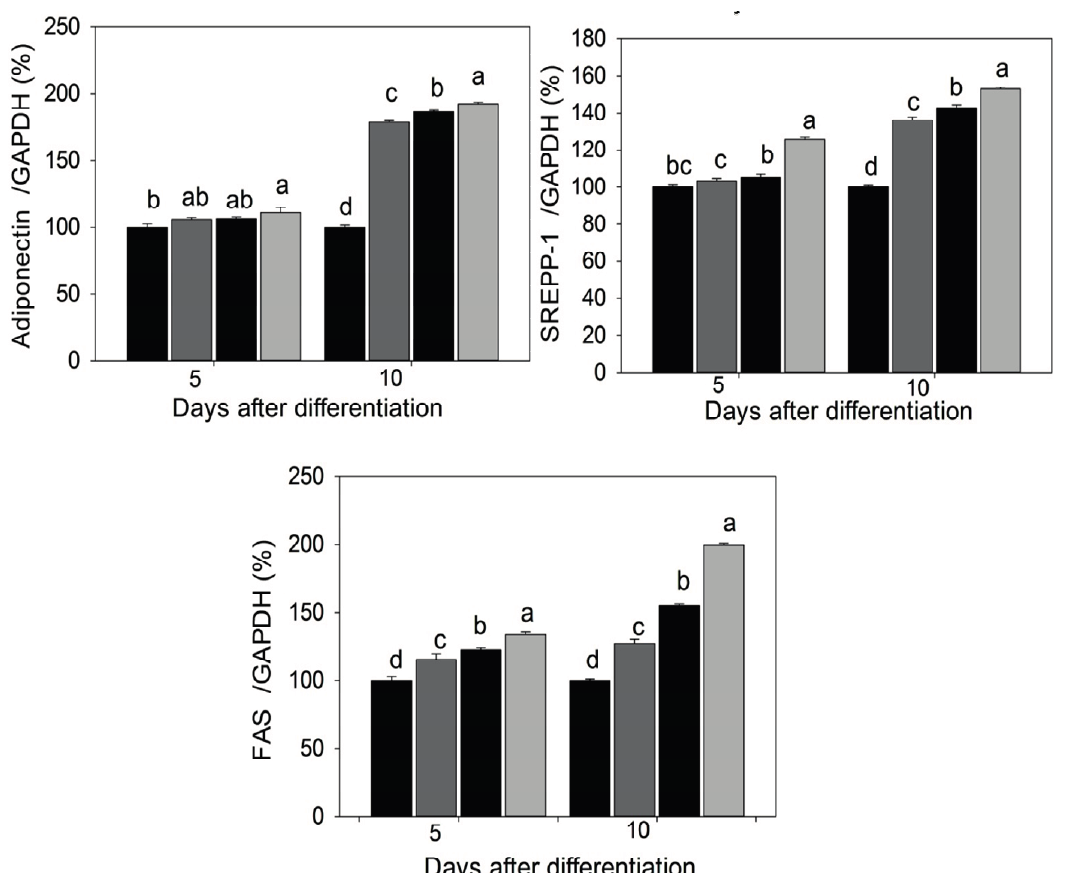
Figure 4. PPAR- γ 2, C/EBP- α , adiponectin, SREBP-1 and FAS mRNA expression pattern in differentiated adipocytes were analyzed by qPCR. Data were shown as means ± SEM of six replicates. Different letters a, b, c, d within a treatment indicate a significant difference ( p < 0.05).